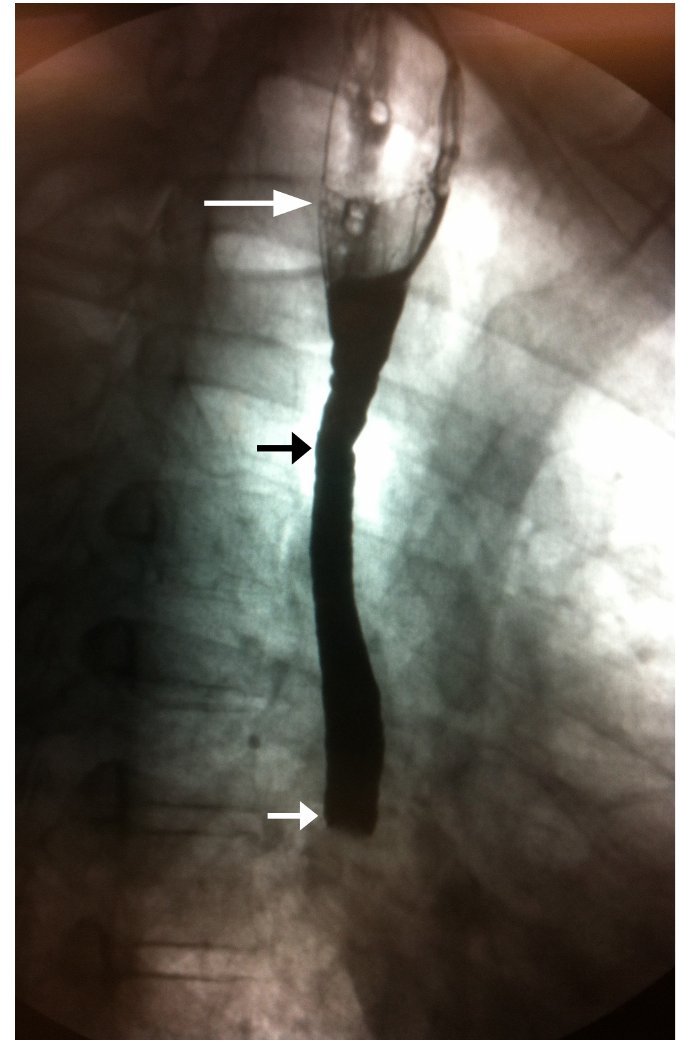
Figure. Barium esophagram. Grossly abnormal esophagram with dilated proximal esophagus (white arrow), abnormal appear- ance of middle one-third (short black arrow) and abrupt cutoff of ingested barium contrast material (short white